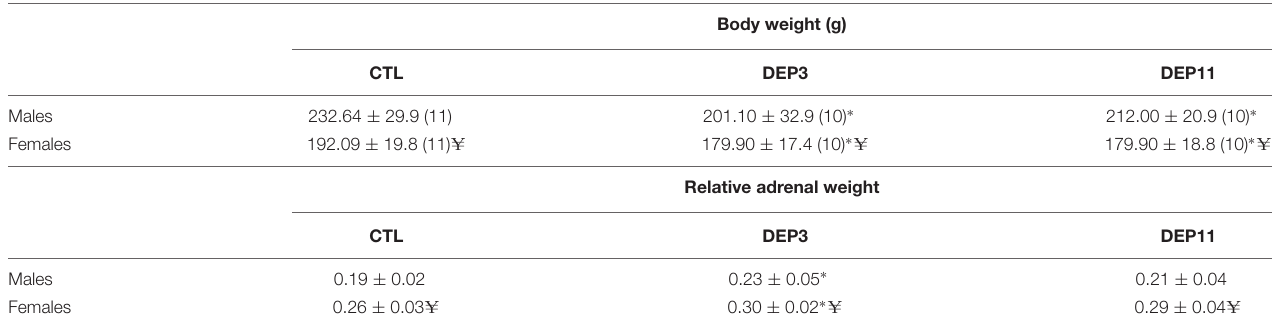
TABLE 1 | Body and relative adrenal weights of adolescent male and female rats, kept with the mother – control (CTL) or maternally deprived on postnatal days 3 (DEP3) or 11 (DEP11).